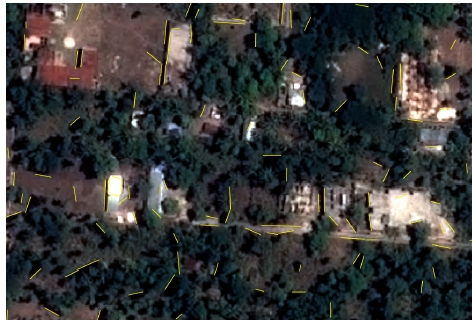
Figure 9. Line segments detection in an extract of Haiti case mation correctly (Fig.